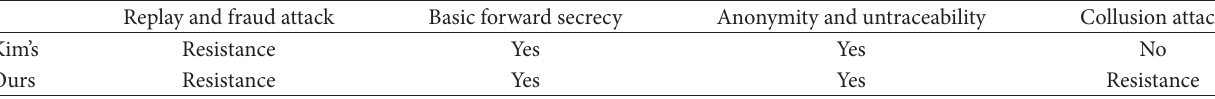
Table 1: Security and functionality comparison with Kim’s scheme.